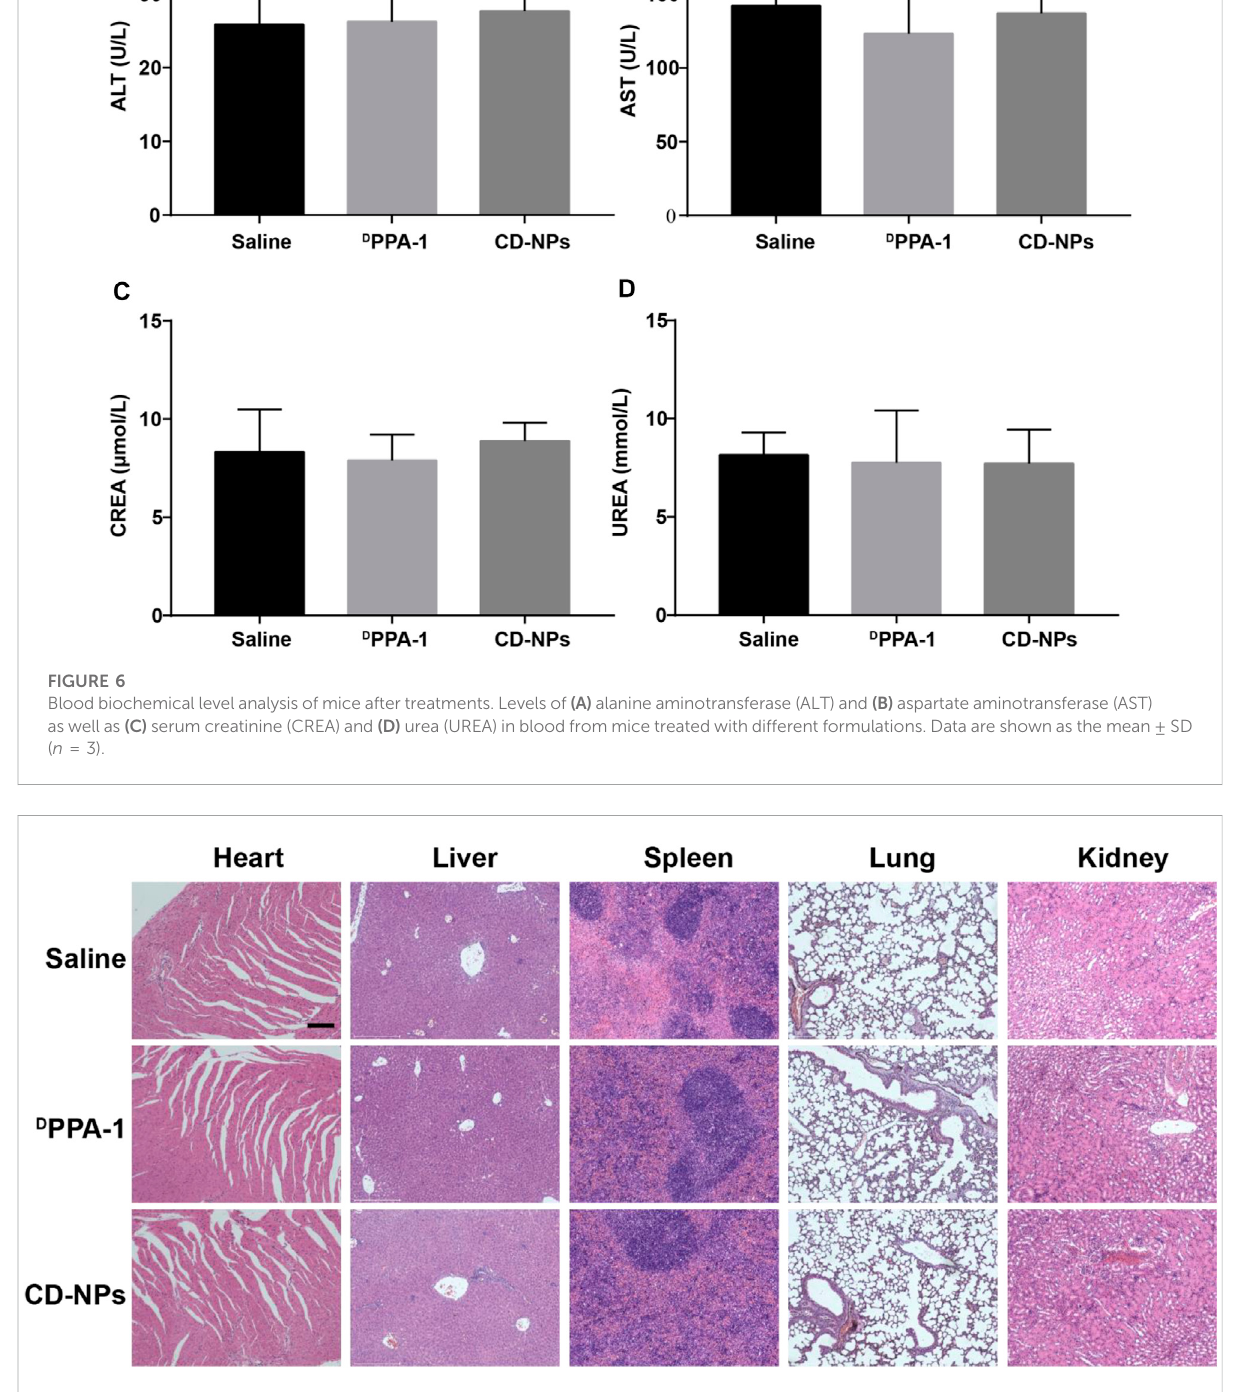
Representative images of H&E staining of hearts, livers, spleens, lungs, and kidneys of mice treated with different formulations. Scale bars, 200 μ m.